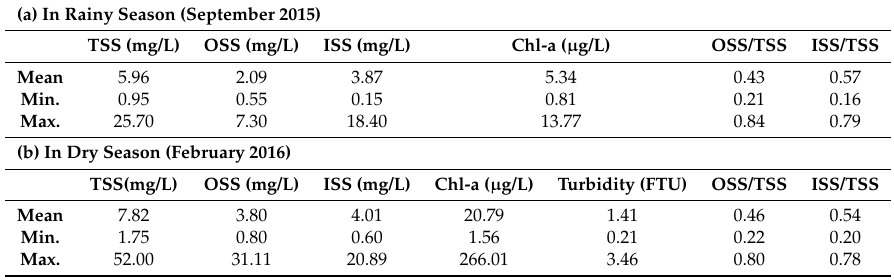
Table 4. Mean, minimum and maximum values of water quality variables in (a) rainy season (September 2015) and (b) dry season (February